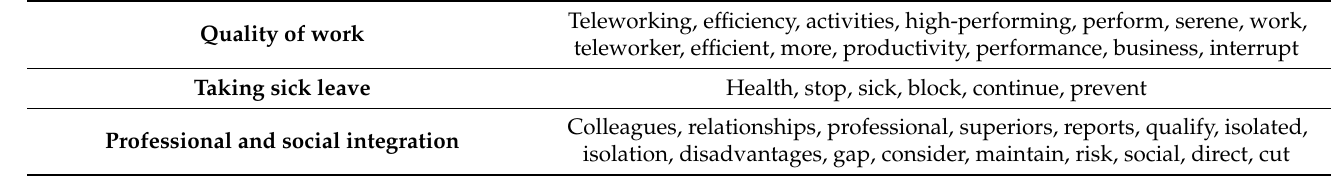
Table 5. Themes associated with the specific vocabulary of Class 4. Quality of